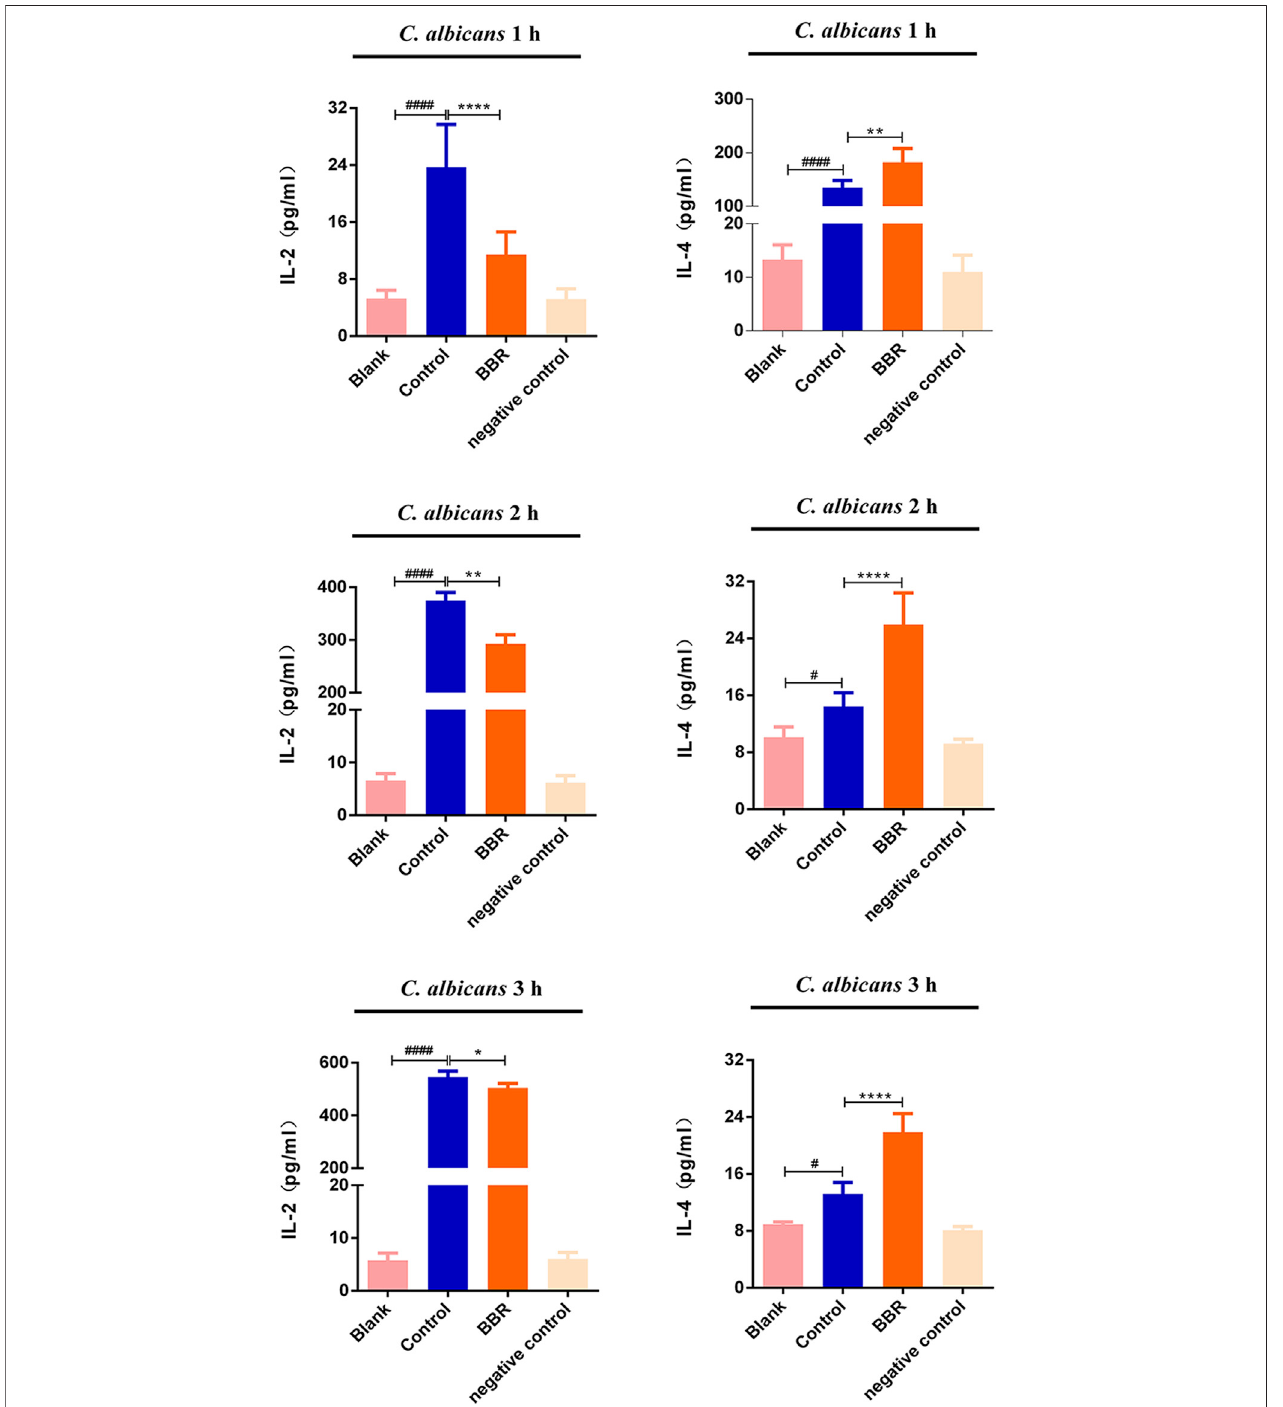
FIGURE 6 | The levels of IL-2 and IL-4 in the Blank, Control, BBR(32 μ g/ml) and negative control groups at 1 h (upper), 2 h (middle)and 3 h (lower), respectively. # p < 0.05, #### p < 0.0001. vs. Blank group; * p < 0.05, ** p < 0.01, **** p < 0.0001. vs. Control group. Scale bar, 20 μ m.